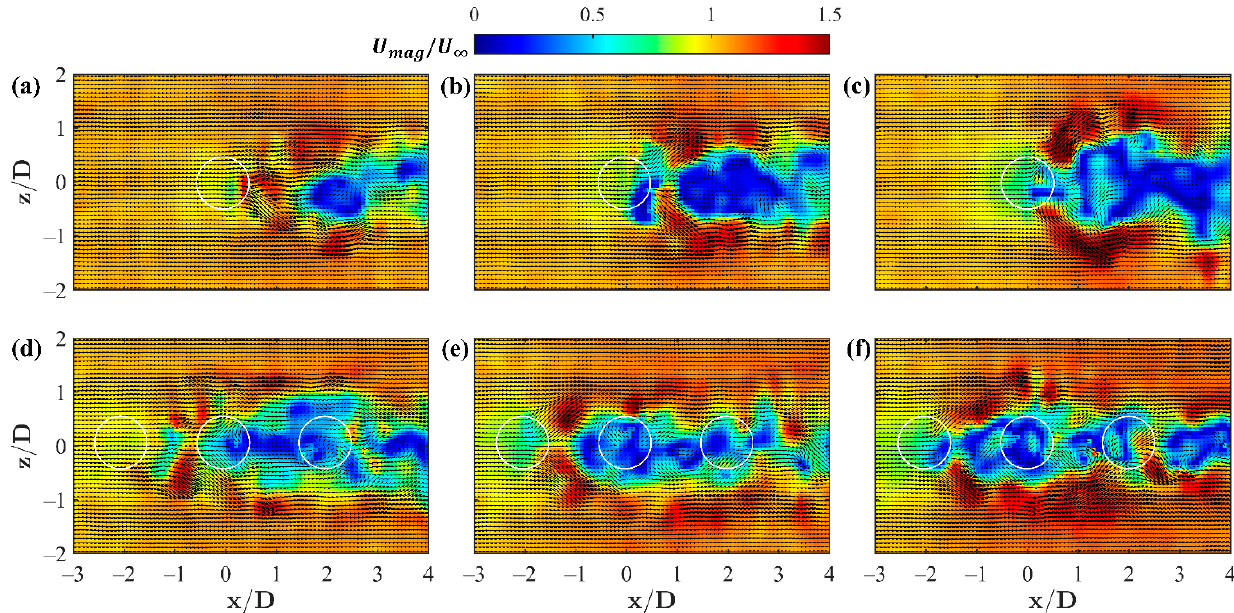
Figure 3. Instantaneous velocity magnitudes U mag /U ∞ with vector components U and W. Rows depict ( a – c ) single and ( d – f ) triple jets with white circles and columns ( a , d ), ( b , e ), and ( c , f ) correspond to V j /U ∞ = 0.9, 1.25, 1.7, respectively. Reproduced with permission from Kristo and Kimber, Time-resolved particle image velocimetry measurements of a tandem jet array in a crossflow at low velocity ratios [15]; published by Springer Nature, 2021.